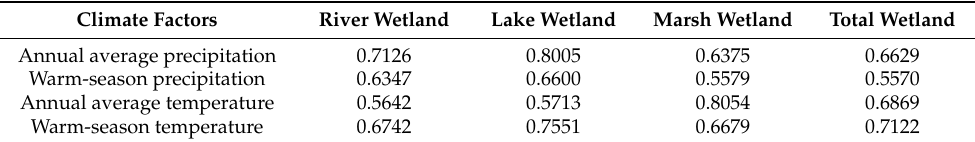
Table 7. The grey relation between the wetland area and climatic factors in the YRSNP from 2000 to